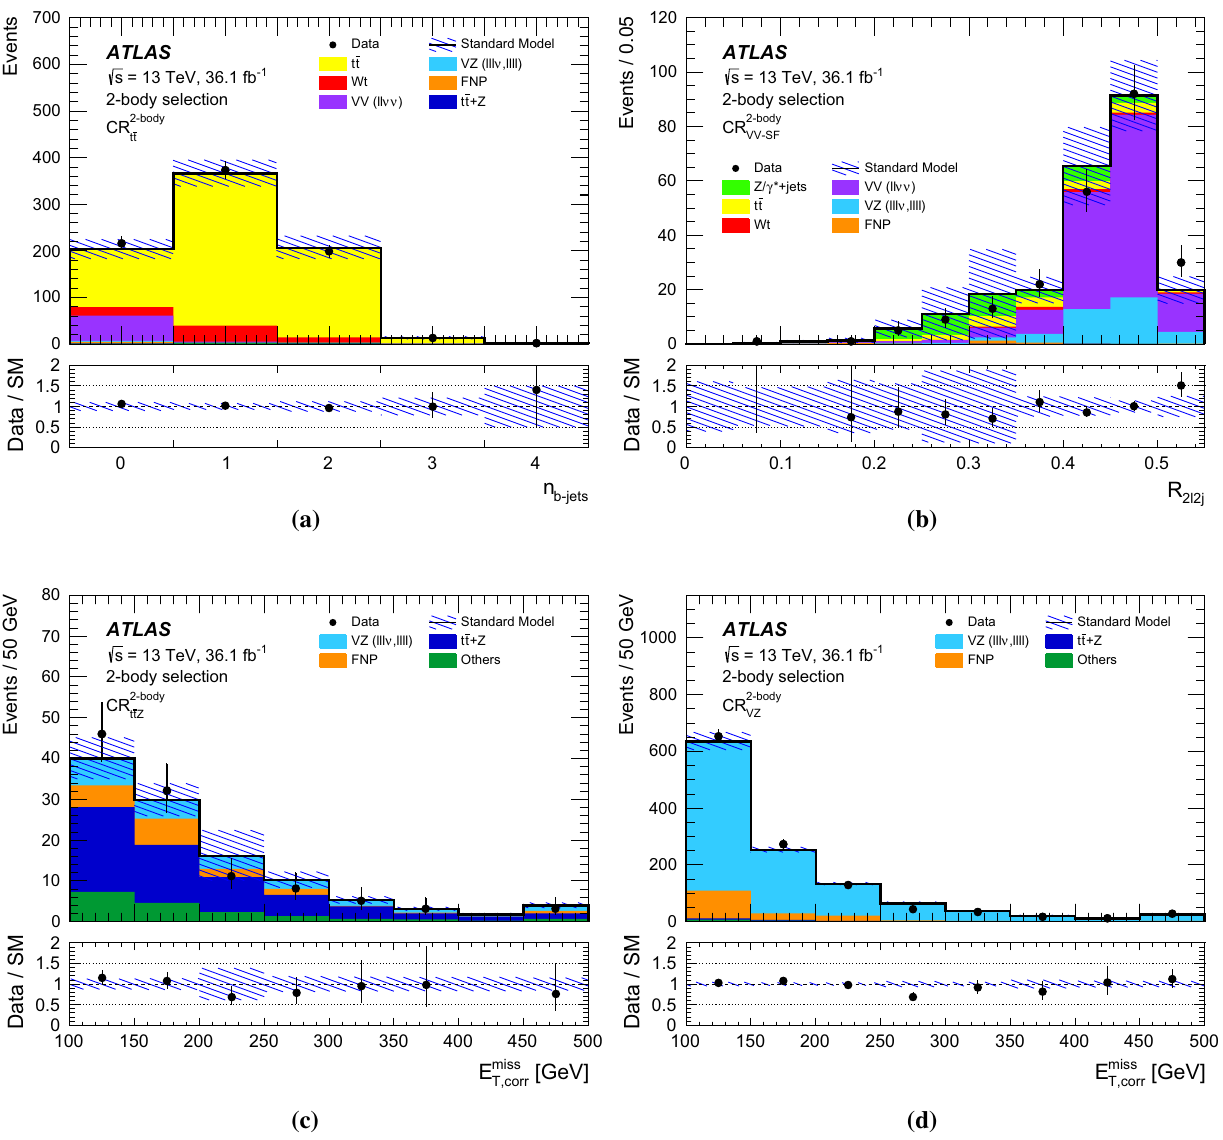
Fig. 2 Two-body selection distributions of a n b -jets in CR 2-body R 2 (cid:3) 2 j in CR 2-body and c , d E miss T , corr in CR 2-body VV -SF SRA 2-body